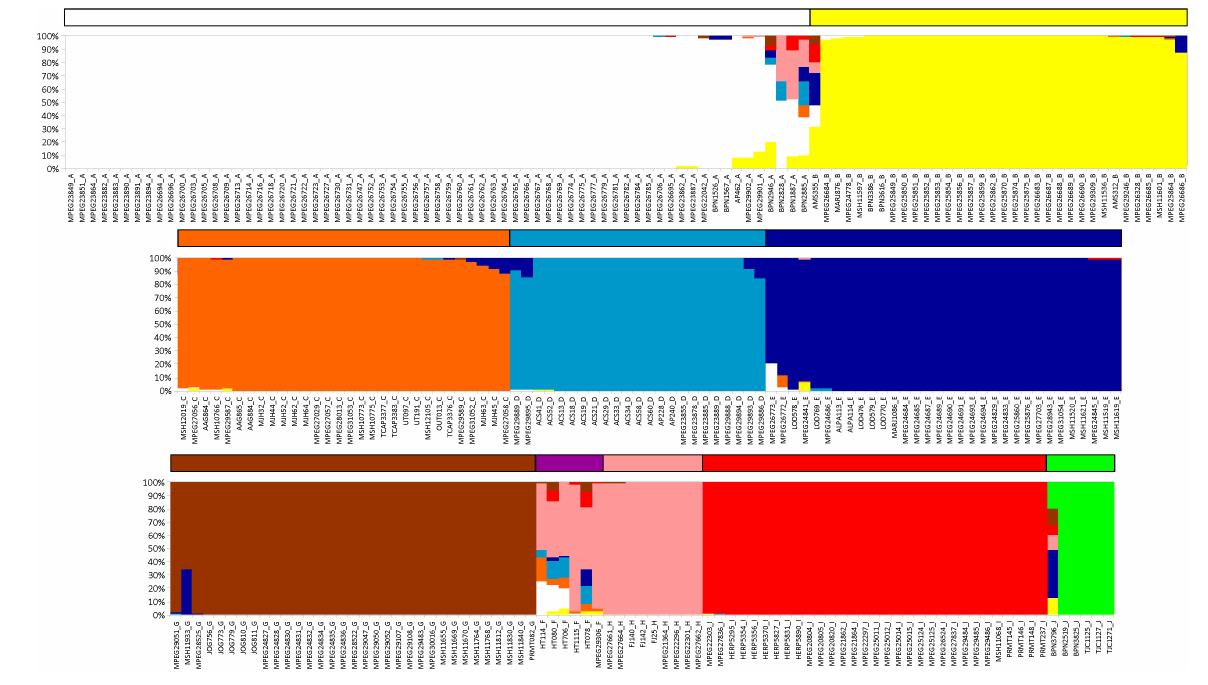
FIGURE 2 | Barplots resulting from populational structure analysis performed on BAPS, based on concatenated mtDNA. Bar colors correspond to the color groups recovered in Figure 1 (upper = clade AB; middle = clade CDE; lower = J + clade GHI +